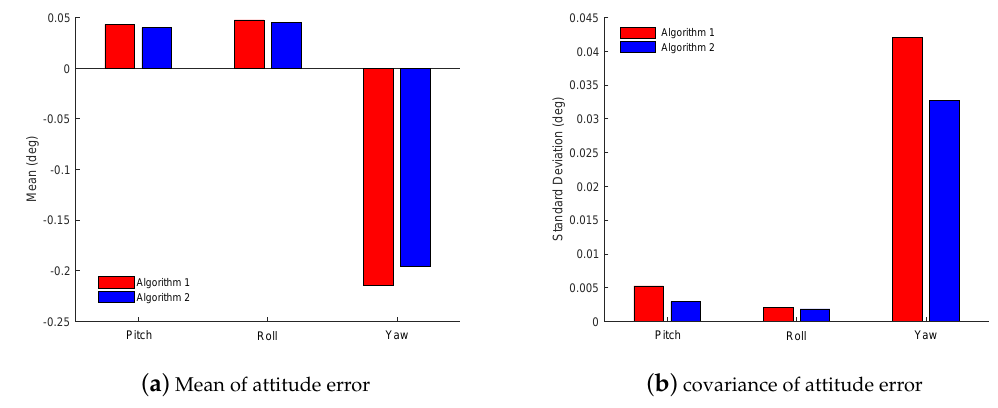
Figure 11. Attitude error statistical property with different initial alignment algorithms. ( a ) is the mean of the pitch, roll and yaw angle errors and ( b ) is the standard deviation of the the pitch, roll and yaw angle errors. The red bar denote the errors obtained by utilizing Algorithm 1 while the blue bar denotes the errors obtained by utilizing Algorithm